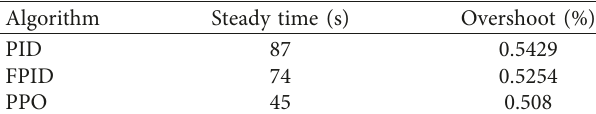
Table 6: Performance indicators of the three algorithms when the feedwater temperature steps down to 50 ° C.